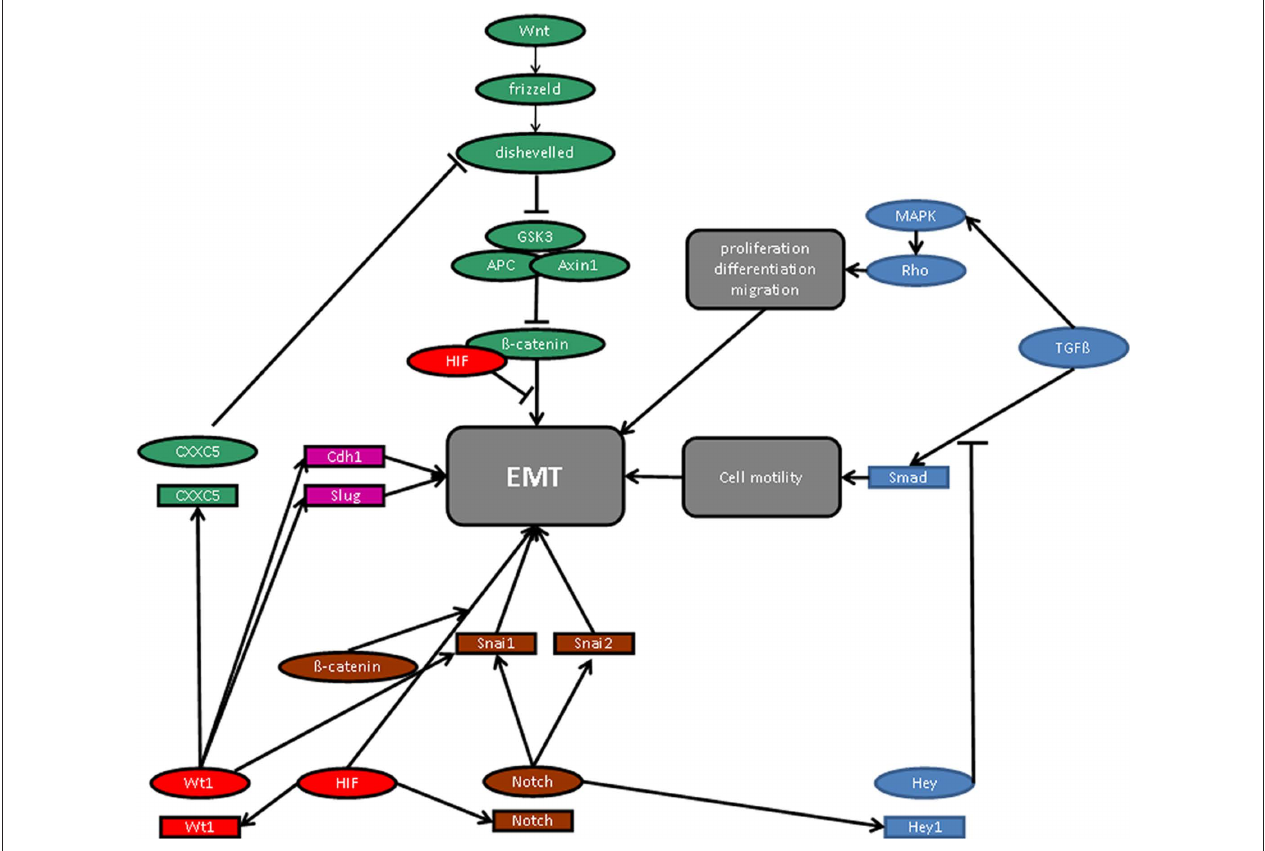
FIgure 2 | Molecular signaling pathways in epithelial-to-mesenchymal transition (eMT). For details see manuscript